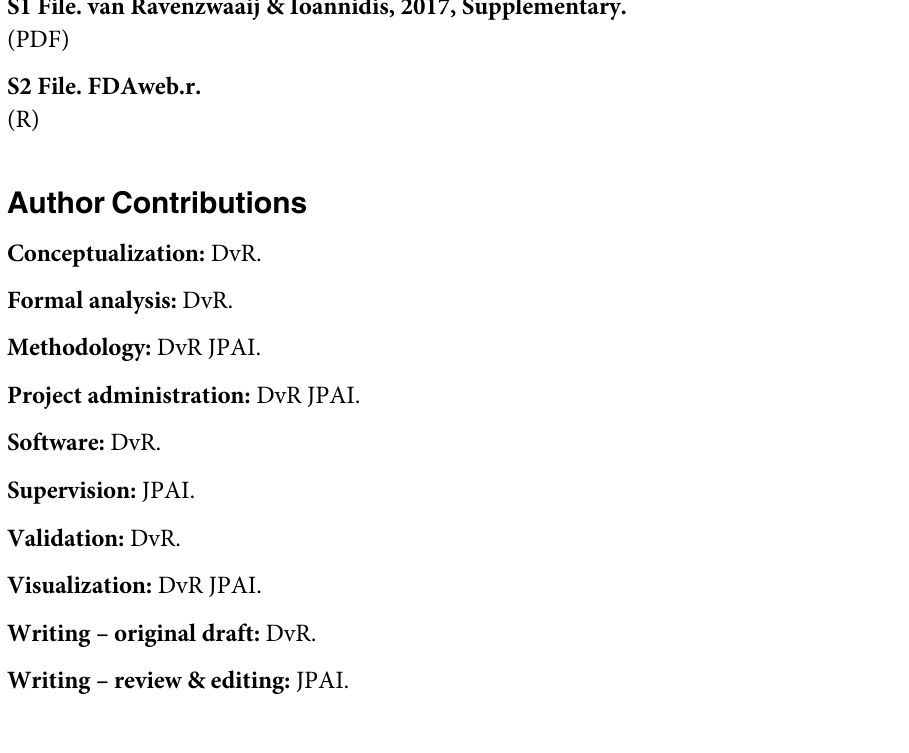
S6 Fig. Proportion of Bayes factors in favor of the alternative hypothesis lower than 1 (black), between 1 and 3 (red), between 3 and 20 (green), and higher than 20 (blue) for two significant trials when the true effect size is 0.5 and the standard deviation is not equal between groups. (TIF) S7 Fig. Bayes factors in favor of the alternative hypothesis for two significant trials when the true effect size is 0 and the standard deviation is not equal between groups. Boxes con- tain Bayes factors for 50% of the simulations with tails extending to Bayes factors for 100% of the simulations. (TIF) S8 Fig. Proportion of Bayes factors in favor of the alternative hypothesis lower than 1 (black), between 1 and 3 (red), between 3 and 20 (green), and higher than 20 (blue) for two significant trials when the true effect size is 0 and the standard deviation is not equal between groups. (TIF) S9 Fig. Bayes factors in favor of the alternative hypothesis for two significant trials when the true effect size is variable and the standard deviation is not equal between groups. Boxes contain Bayes factors for 50% of the simulations with tails extending to Bayes factors for 100% of the simulations. (TIF) S10 Fig. Proportion of Bayes factors in favor of the alternative hypothesis lower than 1 (black), between 1 and 3 (red), between 3 and 20 (green), and higher than 20 (blue) for two significant trials when the true effect size is variable and the standard deviation is not equal between groups.